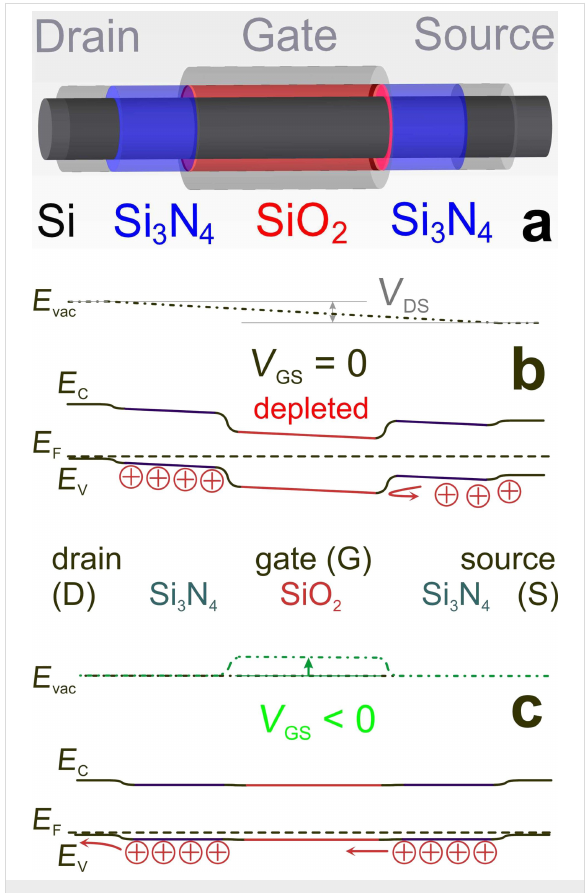
Figure 7: Concept of an undoped FET consisting of a Si-NWire with drain/gate (channel)/source regions covered by ultrathin Si 3 N 4 /SiO 2 / Si 3 N 4 : (a) physical layout shown for self-blocking p-channel FET. Schematic band diagram of such an FET shown for (b) zero and (c) negative gate bias relative to source voltage, resulting in a conduc- tive channel by shifting the electronic Si-NWire states pinned by SiO 2 . Interchanging Si 3 N 4 and SiO 2 layers yields self-blocking n-channel FETs and thereby CMOS-compatibility. This concept is applicable to other Si nanostructures with a high surface-to-volume ratio like fin- FETs.